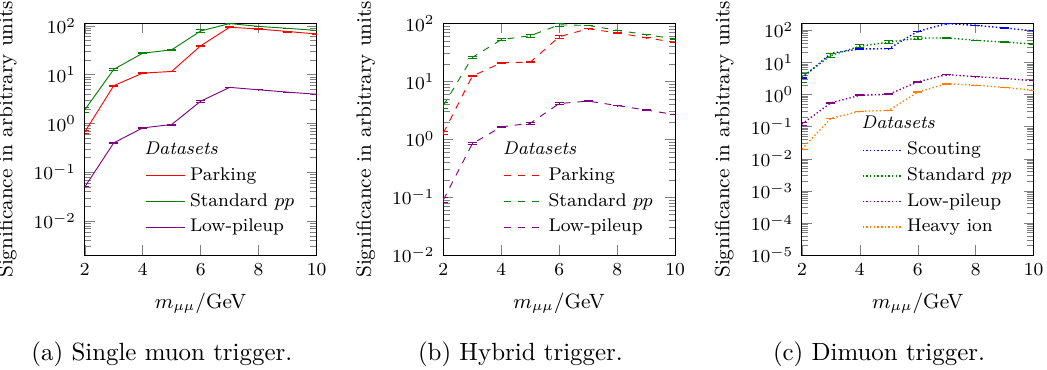
Figure 5 : Comparison of the significance to discover the displaced low- p signal in arbitrary units T as a function of the dimuon invariant mass. The comparison between the relevant datasets is shown for the single muon (a), hybrid (b), and dimuon (c) trigger scenarios during Run 2. suggests the importance of the high p threshold that the single muon and hybrid trigger T scenarios impose on the muon candidates in comparison to the dimuon trigger scenario. On the other hand, for m µµ ≤ 6 GeV the hybrid trigger scenario proves the most competitive favouring the combination of the high p threshold along the displacement of both muon T